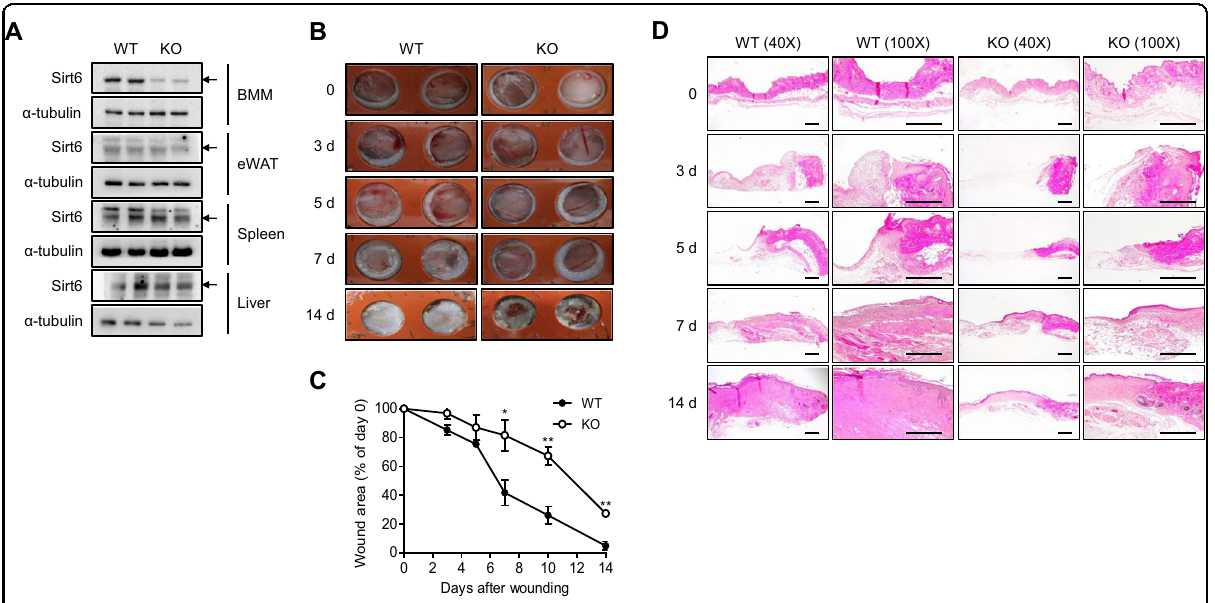
Fig. 1 Delayed wound healing in mS6KO mice. a The process used to generate myeloid cell-speci fi c Sirt6 knockout (mS6KO) mice is shown. b Excisional wounds were made by 6-mm-diameter punches. The wound sites were photographed at the indicated time. A day 0 picture was taken immediately after injury. Representative results from fi ve individual mice from each group are shown. c Wound photographs were analyzed at the indicated times to determine wound closure in WT and KO mice. Values represent the mean ± SEM ( n = 8). * p < 0.05 and ** p < 0.01 vs. WT. d Histological sections of mouse skin wounds were examined by H&E staining. Bars = 250 μ